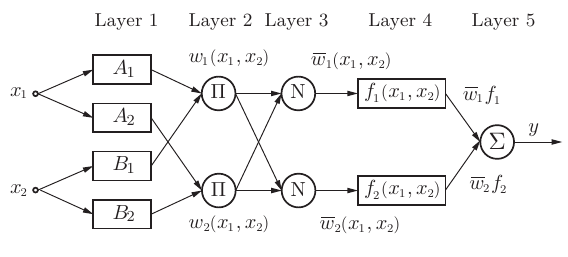
Figure 1: ANFIS network